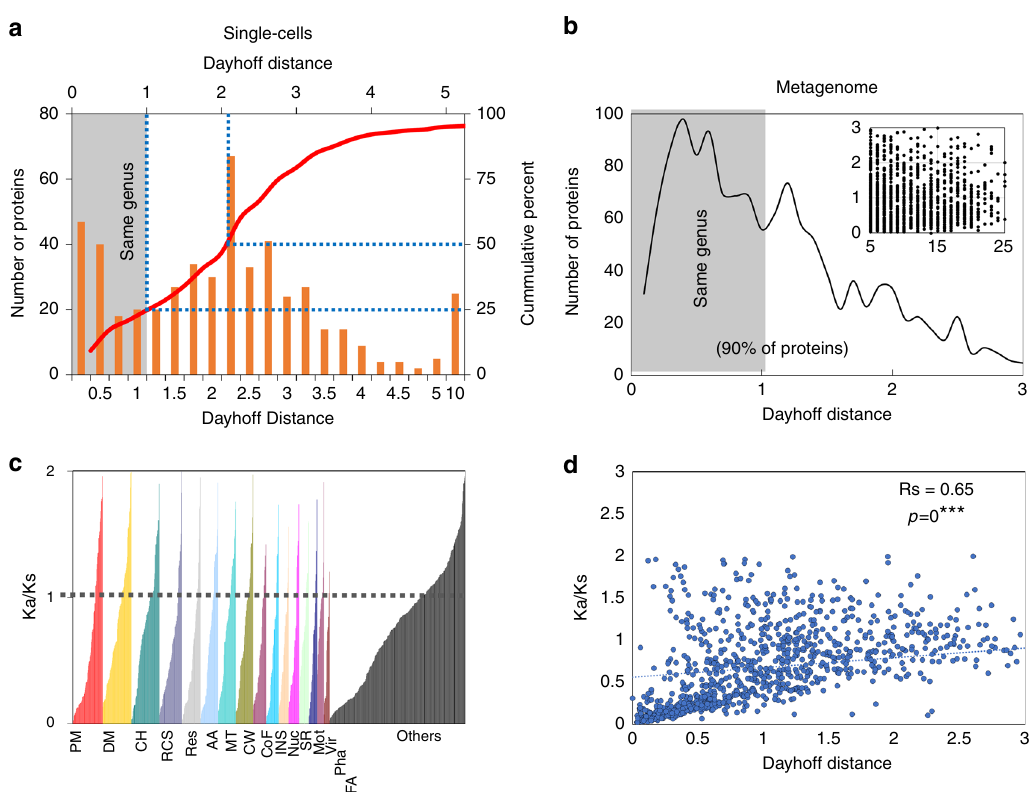
Fig. 7 Distances between multiple copies of the same protein and conservation pressure. a Protein numbers ( n = 505) distribution along the average Dayhoff distance across single cells, between proteins with multiple copies per single cells. The curve shows the cumulative percent of total proteins. A similar distribution across all single cells is shown in Supplementary Fig. 8. b Protein numbers ( n = 1400) distribution along the Dayhoff distance (0 – 3), showing a decreasing number of proteins as the distance increases. The insert shows the lack of correlation between distance ( Y axis) and gene copy number ( X axis). c Ratio between non-synonymous and synonymous mutations (Ka/Ks) calculated for 1040 proteins grouped based on the fi rst level of the seed subsystem 32 hierarchical system. The dashed line at a ratio of 1 marks proteins inferred under conservation pressure (Ka/Ks < 1), stable (Ka/Ks = 1), and evolving (Ka/Ks > 1). The seed groups are labeled as follows: AA amino acids and derivatives; CH carbohydrates; CoF cofactors, vitamins, prosthetic groups, pigments; CW cell wall and capsule; DM DNA metabolism; FA fatty acids, lipids, and isoprenoids; INS iron, nitrogen and sulfur metabolism (small groups combined for plotting purposes); Mot motility and chemotaxis, MT membrane Transport; Nuc nucleosides and nucleotides; Others smaller groups and non-classi fi able proteins; Pha phages, prophages, transposable elements, Plasmids; PM protein metabolism; RCS regulation and cell signaling; Res respiration; SR stress response; Vir virulence, disease and defense. d Correlation between protein distance and the Ka/Ks ratio (Spearman Rs =